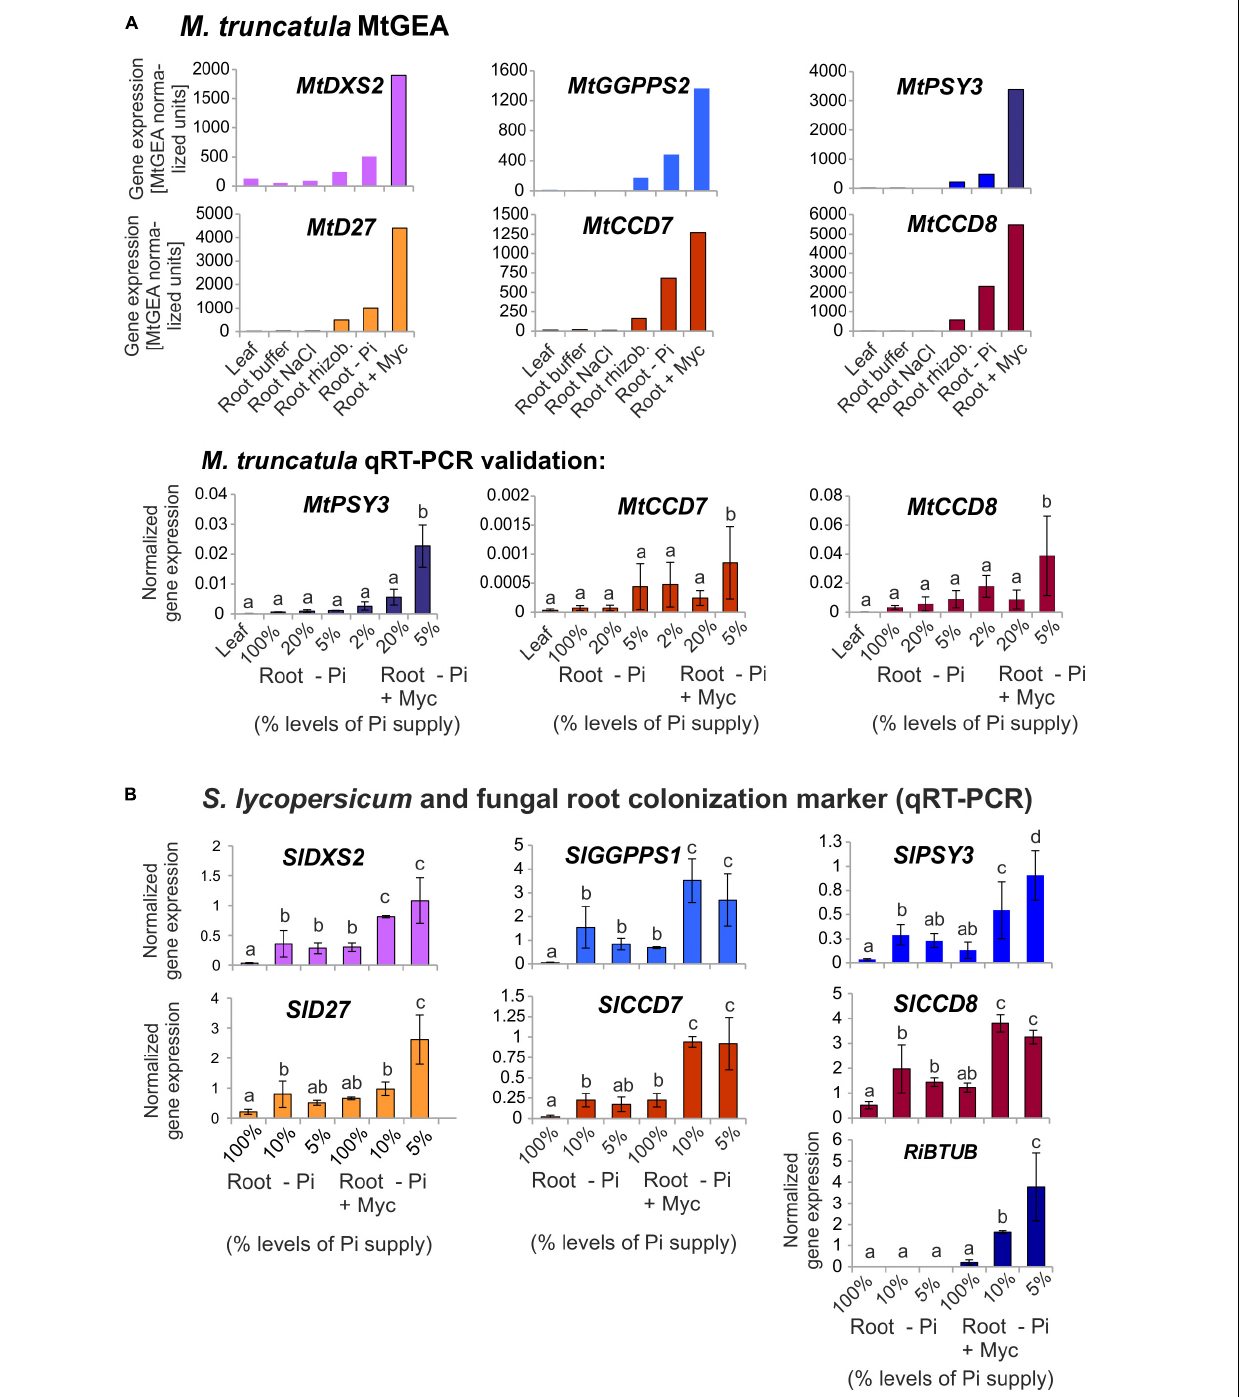
FIGURE 7 | Coexpression analysis of MtPSY3 and SlPSY3 with isogenes in upstream and downstream steps. (A) M. truncatula gene transcript data for candidate genes retrieved from MtGEA using a limited probeset (# 1, 9, 10, 15, 18, 21) out of 22 used in the analysis in Supplementary Figure S2. Target genes were DXS2 , GGPPS2 for upstream and D27 , CCD7 , and CCD8 for downstream steps toward SL biosynthesis. MtGEA data for MtCCD7 and MtCCD8 were validated for root treatments by qRT-PCR experiments. qRT-PCR data were normalized to constitutively expressed MtEF1 α . (B) S. lycopersicum samples were analyzed by qRT-PCR using a simplified set of samples. The AM-responsive GGPPS is termed here SlGGPPS1 for historical reasons. MtPSY3 and SlPSY3 data from Figures 2 and 3 are included for comparison. In addition, transcript levels of the fungal RiBTUB gene were determined. Data were normalized to constitutively expressed SlEF1 α . Error bars in qRT-PCR data are derived from SD of four biological replicates. Please note different scales in the various data displays. Error bars derive from SD of two to five biological replicates. Different lower case letters indicate statistically different values in ANOVA followed by a Tukey HSD test ( p ≤ 0.05).